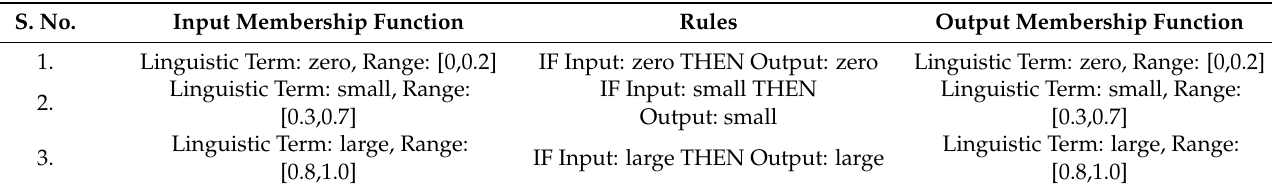
Table 2. Adaptive-PI and A-SMC IF-THEN rules.